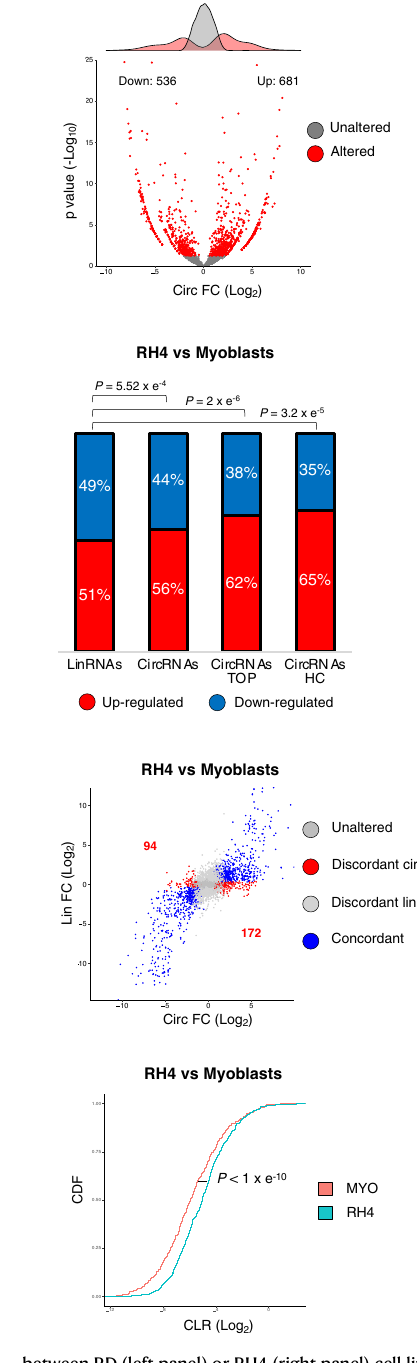
between RD (left panel) or RH4 (right panel) cell lines and wild-type myoblasts. Signi fi cantly deregulated circRNAs are indicated by blue dots when their linear counterpart is deregulated in the same direction ( “ Concordant ” ) and by red dots when the linear is either unaltered or deregulated in the opposite direction ( “ Discordant circ ” ); signi fi cantly deregulated linRNAs are indicated by light gray dots when their circular counterpart is unaltered ( “ Discordant lin ” ); unaffected circRNAs are indicated by dark gray dots when their linear counterpart is not altered ( “ Unaltered ” ). d Cumulative distribution function of the circular versus the linear isoform expression ( “ CLR ” ) in myoblasts (red) and RD (blue, left panel) or RH4 (blue, right panel). P values for the differences between cumulative distribu- tion functions were calculated using Kolmogorov – Smirnov two-tailed test. Source data are provided as a Source Data fi